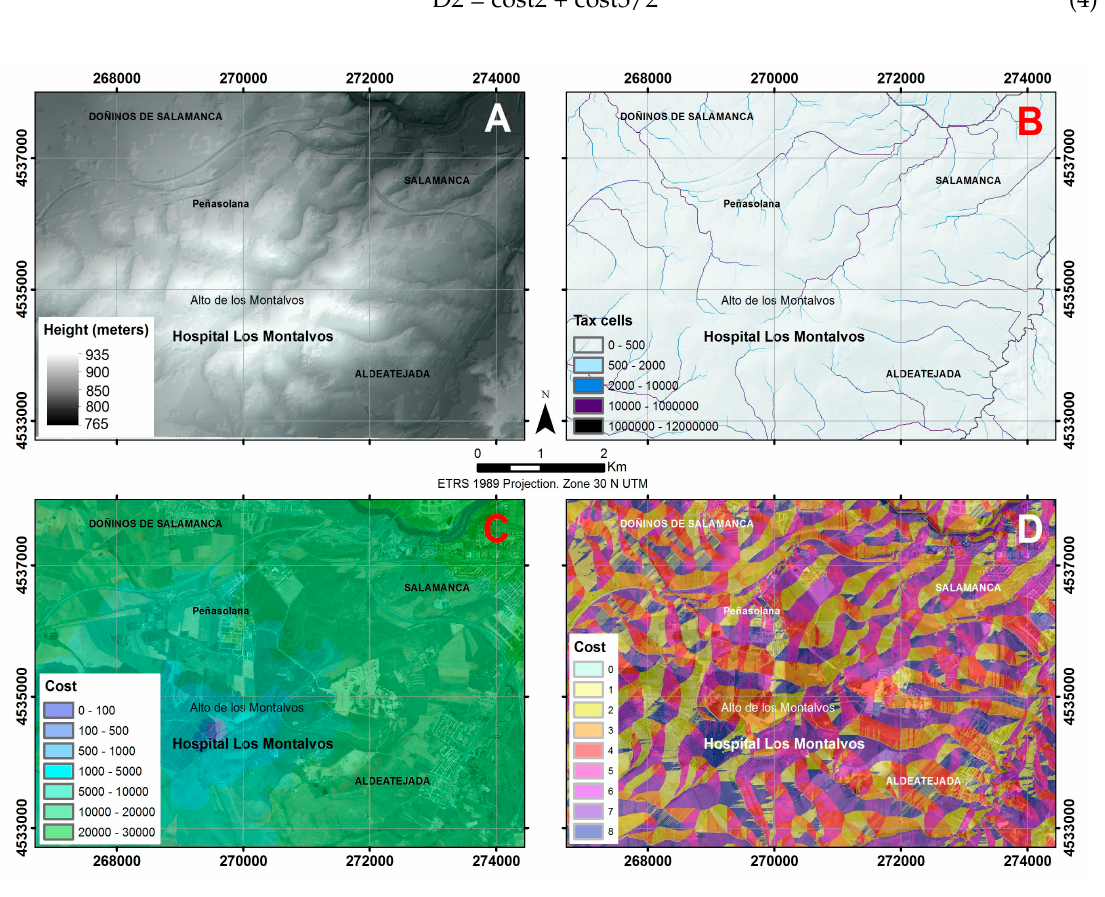
Figure 3. Methodological sequence with GIS (Geographic Information System) technique: digital elevation model ( A ), drainage network ( B ), accumulated costs ( C ) and possible routes map ( D ).